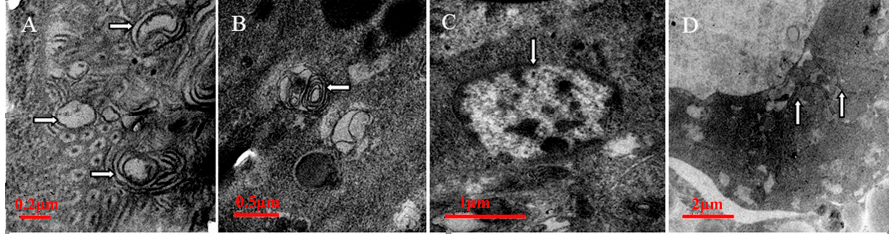
Figure 1. Autophagy in the cells of the highly virulent strain AmA3 of Bursaphelenchus xylophilus after